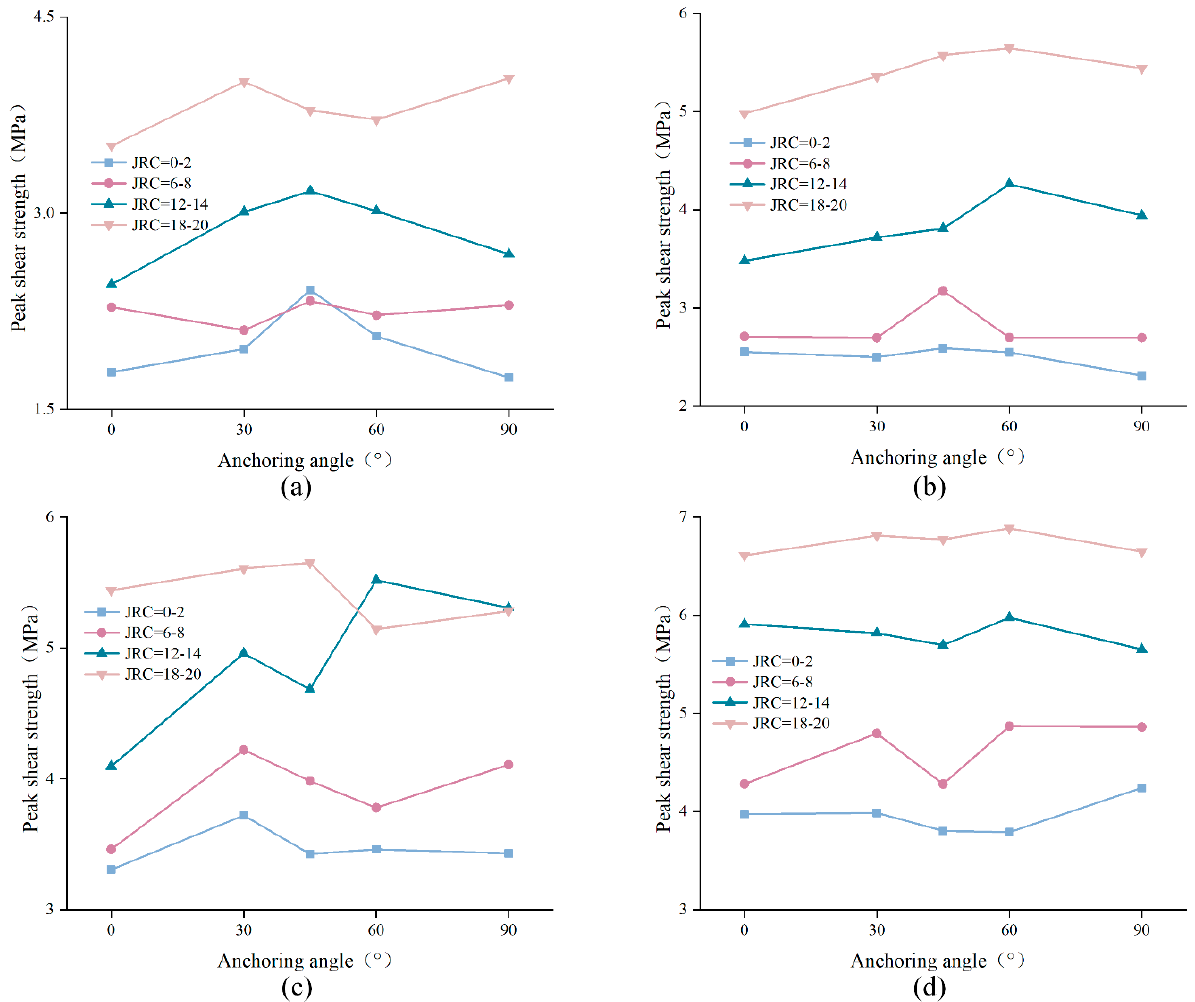
Figure 10. Relationship between shear strength and anchorage angle: ( a ) σ = 2 MPa, ( b ) σ = 3 MPa,